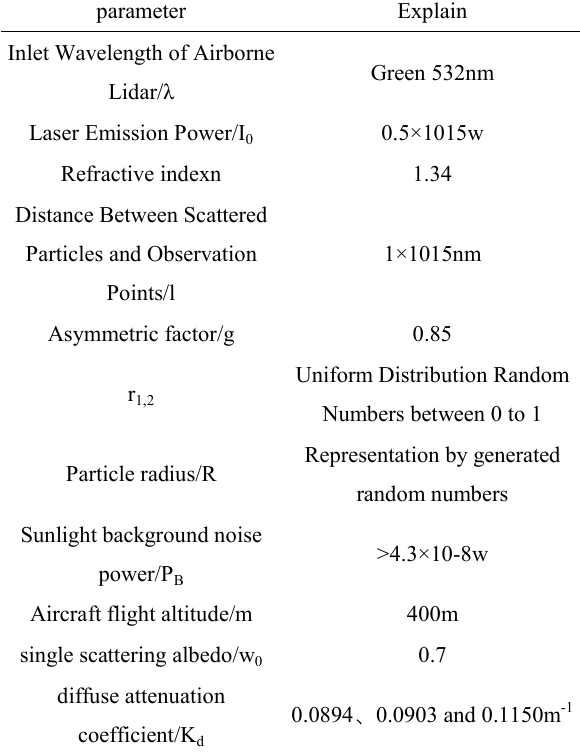
Table 1:Main parameters of simulation experiment parameter